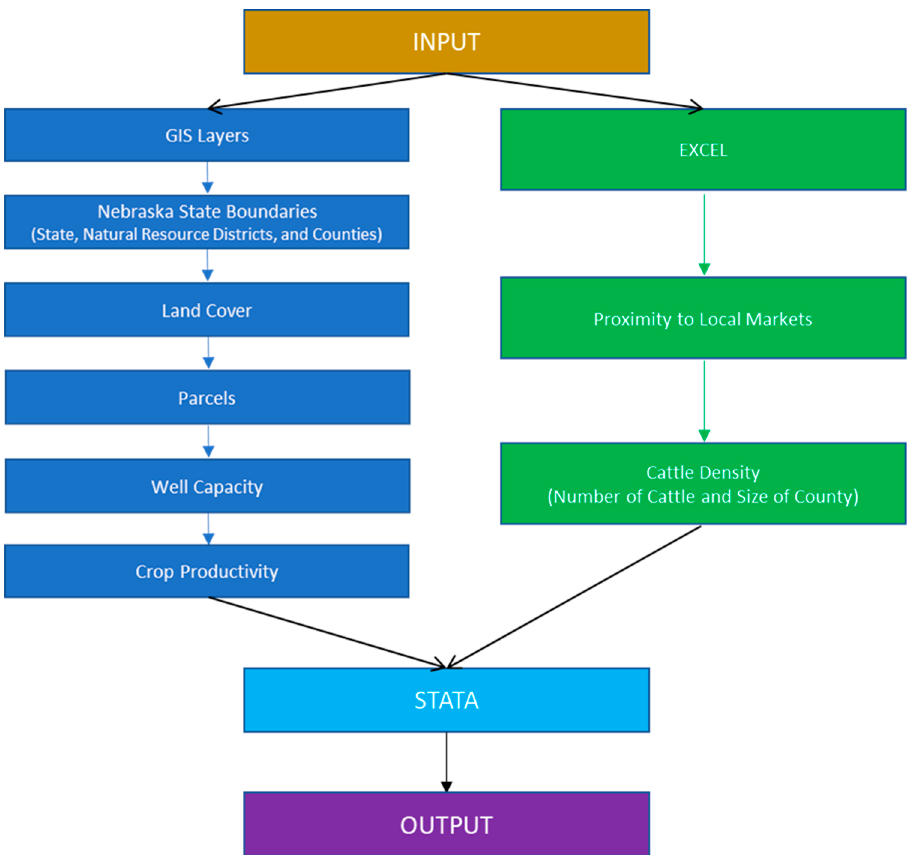
Diagram 1. Data Flowchart.